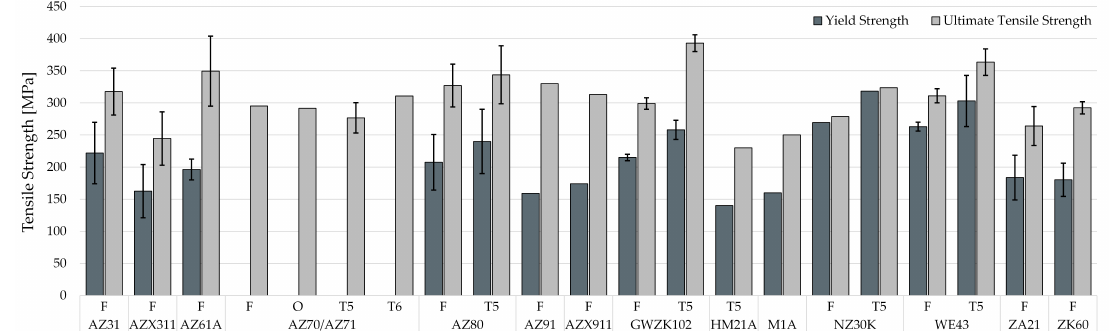
Figure A1. Tensile properties of various forged Mg alloys with differing tempers, tested at RT. The graphic shows mean values calculated from various scientific sources, the error bars show standard deviation. The used sources are listed in Table